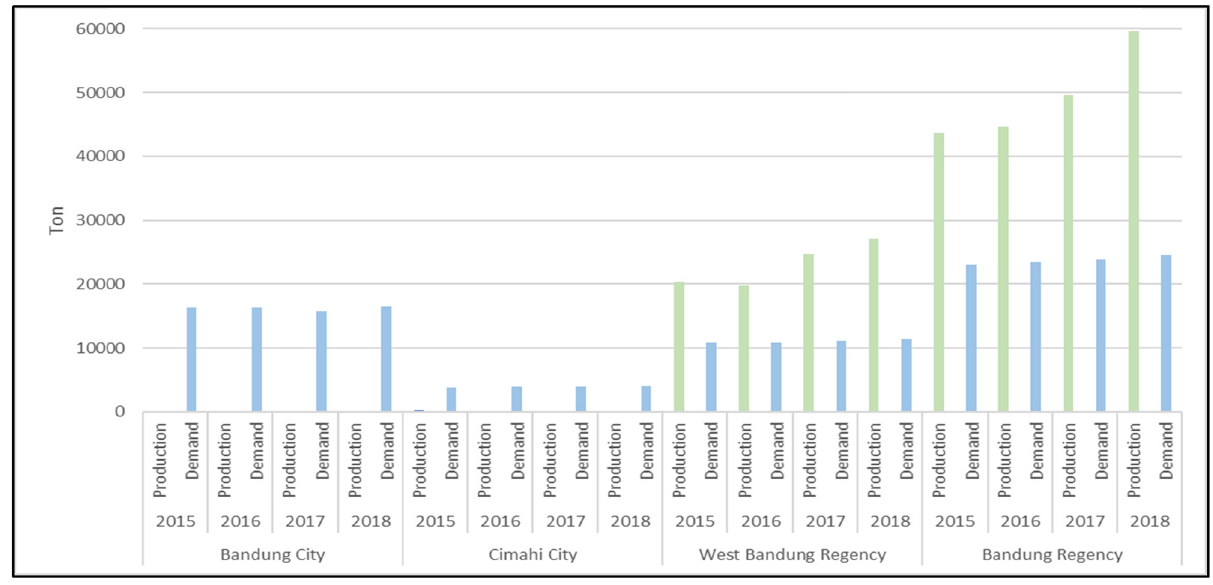
Figure 2: Rice production capacity and demand in Greater